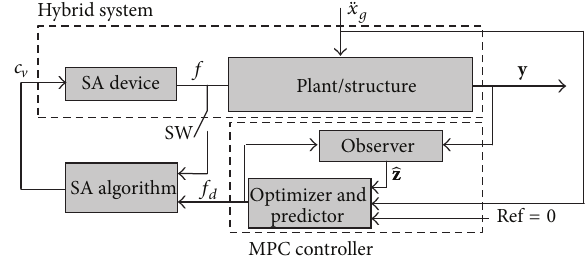
Figure 2: Proposed control loop: force tracking scheme using a MPC controller with a semiactive (SA)